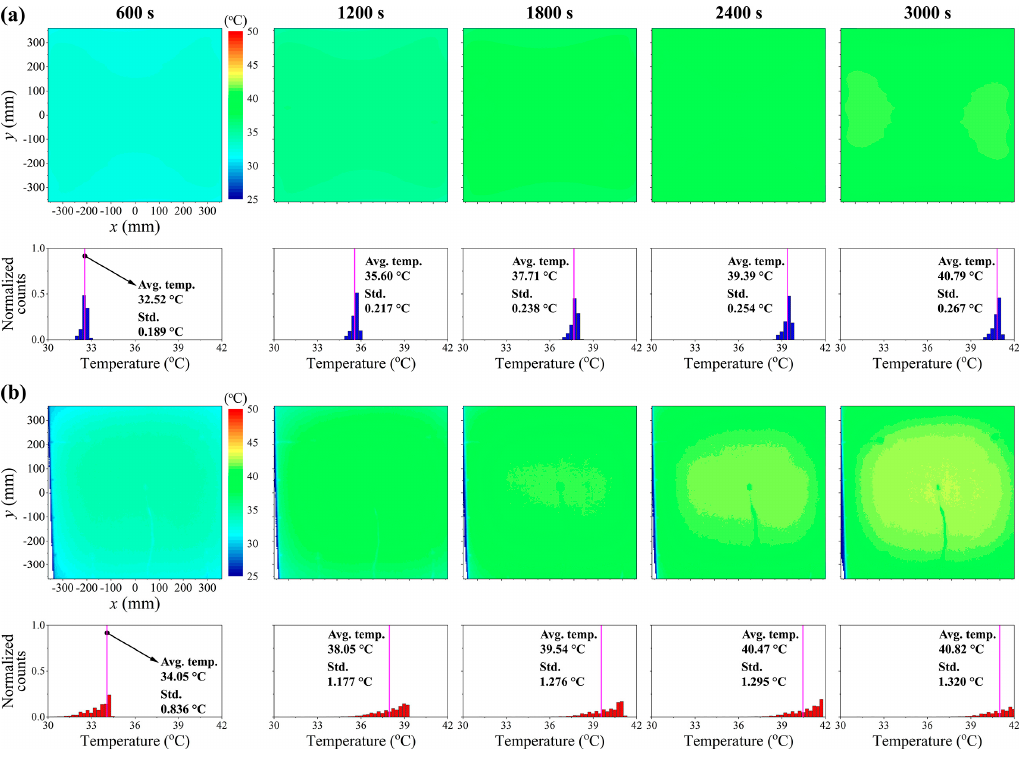
Figure 5. Transient temperature distributions and its histograms of the temperature values on the black surface of the portable and large-area blackbody system at a time interval of 600 s, for a bias voltage of 22.5 V: ( a ) numerical simulation; ( b ) experimental measurement. Note that because the total sampling numbers for the numerical simulation and experimental measurement differ from one another, the y-axis of the histograms indicated the normalized counts by calculating the number of the corresponding temperature value per sampling numbers.